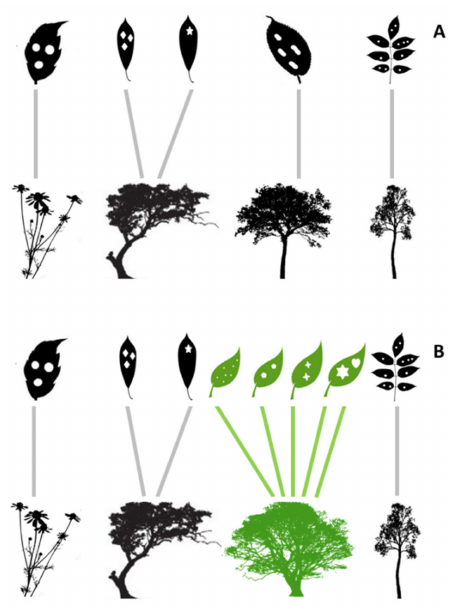
Figure 1. Ecological networks including interaction chains between galling insects (illustrated as insect gall morphotypes in the plant leaves) and host plants. ( A ) A network composed by host plant species (black plants) and galling insect species (black leaves with white insect galls) tends to be characterized by a low number of interactions. ( B ) Occurrence of a superhost plant species (green plant) can a ff ect the number of galling species (green leaves with white insect galls) and links (green arrows) in the network and consequently alters the diversity and connectivity of the plant–galling insect network.